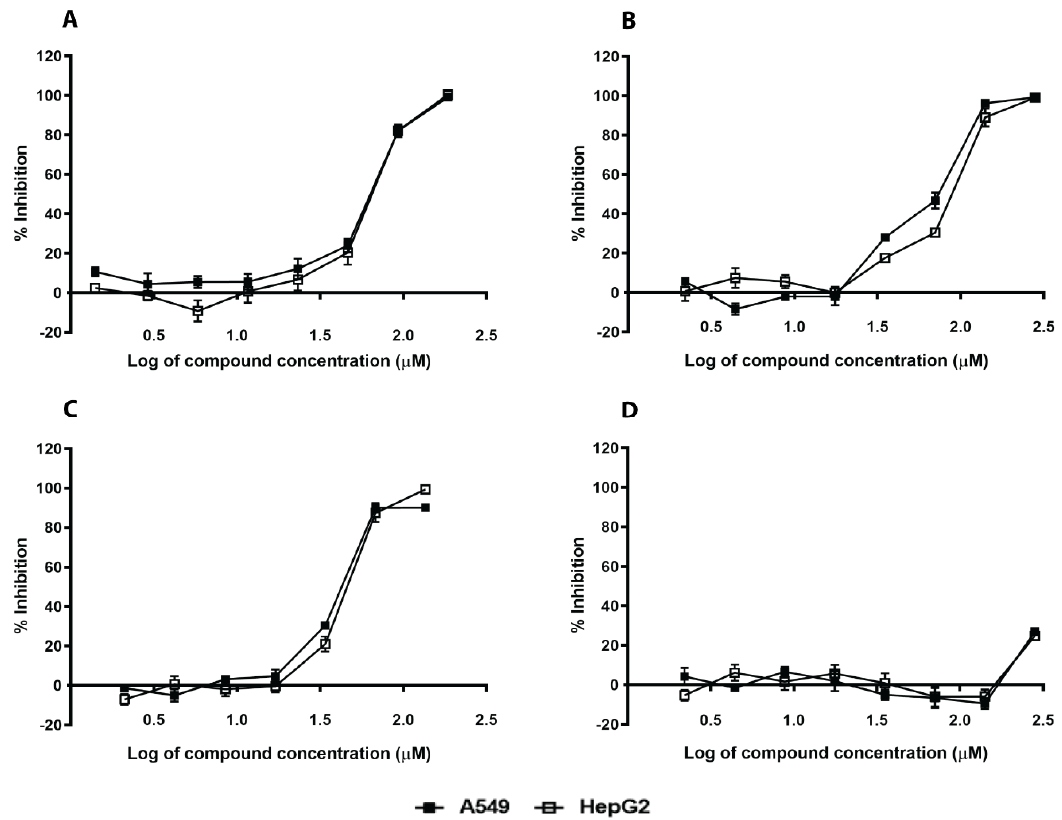
Figure 5. Cytotoxicity of hit compounds and known inhibitors against A549 ( ▪ ) and HepG2 ( □ ) cancer cell lines. N1287 ( A ), N2576 ( B ), curcumin ( C ), and chlorogenic acid ( D ). The results are mean values and SE of three replicates.